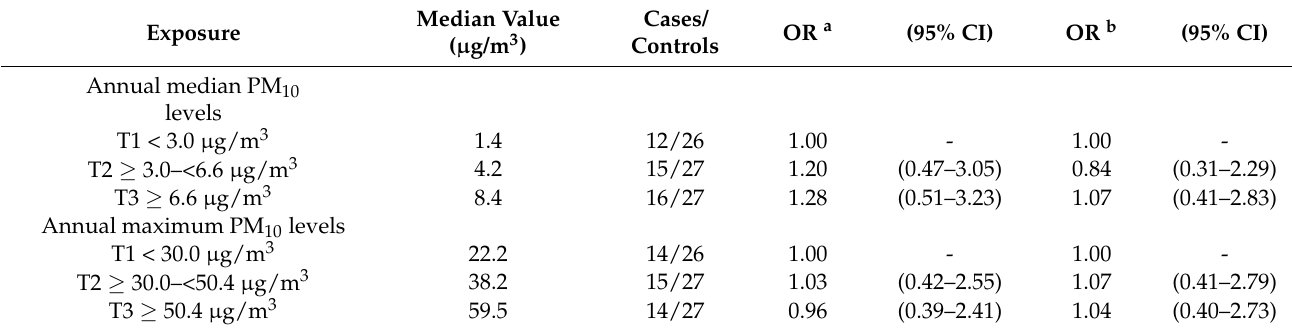
Table 5. Risk of amyotrophic lateral sclerosis according to particulate matter (PM 10 ) exposure in subjects with stable residence within five years of diagnosis using tertile distribution.